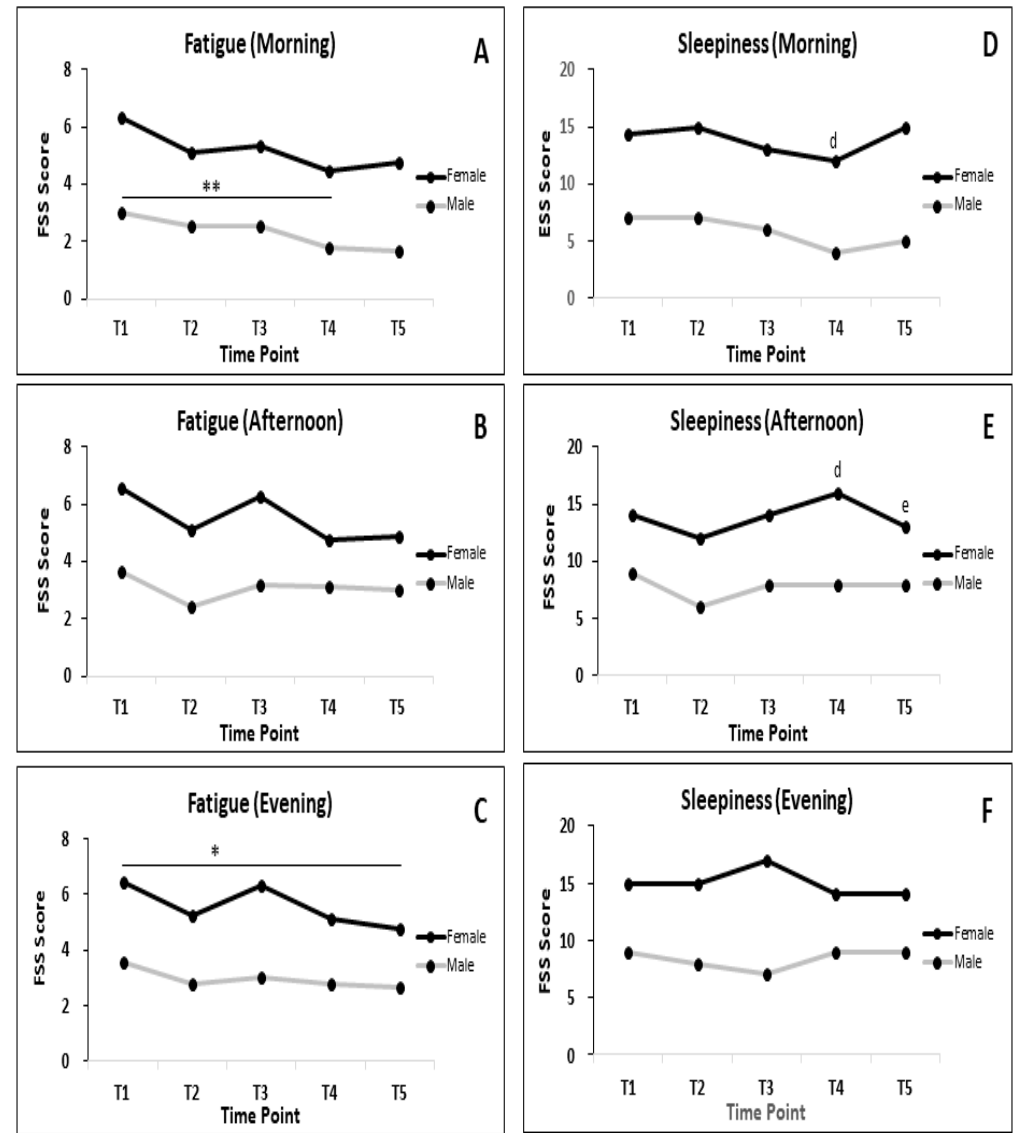
Figure 3. ( A , D ) Patterns of fatigue and sleepiness during RF in male and female in the morning; ( B , E ) afternoon and ( C , F ) and evening; (d,e) significant difference between male and female at T4 and T5, respectively. n at each time point for male = 19, female = 15. Data presented as median. * p < 0.05; ** p < 0.01.